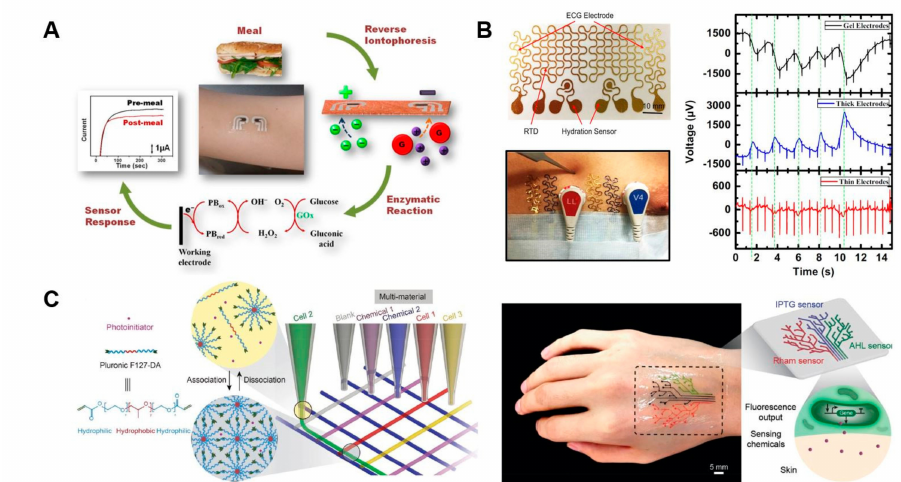
Figure 6. Schematic of implantable devices. ( A ) Tattoo-based glucose detection platform. ( B ) Photograph of an e-tattoo incorporating two electrocardiogram (ECG) electrodes, two hydration sensors and an RTD, all in filamentary serpentine (FS) layout. Synchronously measured ECG under skin indentation. ( C ) Schematic illustration shows direct hydrogel ink writing. The packing of Pluronic F127-DA micelles in the ink leads to a physically crosslinked hydrogel after printing; photoinitiator allows postphotocrosslinking of the living structures after printing; engineered bacterial cells are programmed to sense the signaling chemicals. 3D printed living tattoo is printed as a tree-like pattern on a thin elastomer layer and adhered to human skin. Reproduced with permission from Bandodkar, A.J.; et al. Tattoo-based noninvasive glucose monitoring: A proof-of-concept study; American Chemical Society, 2015 [98], Liu, X.; et al. 3D printing of living responsive materials and devices; Wiley, 2018 [101] and Wang, Y.; et al. Low-cost, µ m-thick, tape-free electronic tattoo sensors with minimized motion and sweat artifacts; Springer Nature, 2018